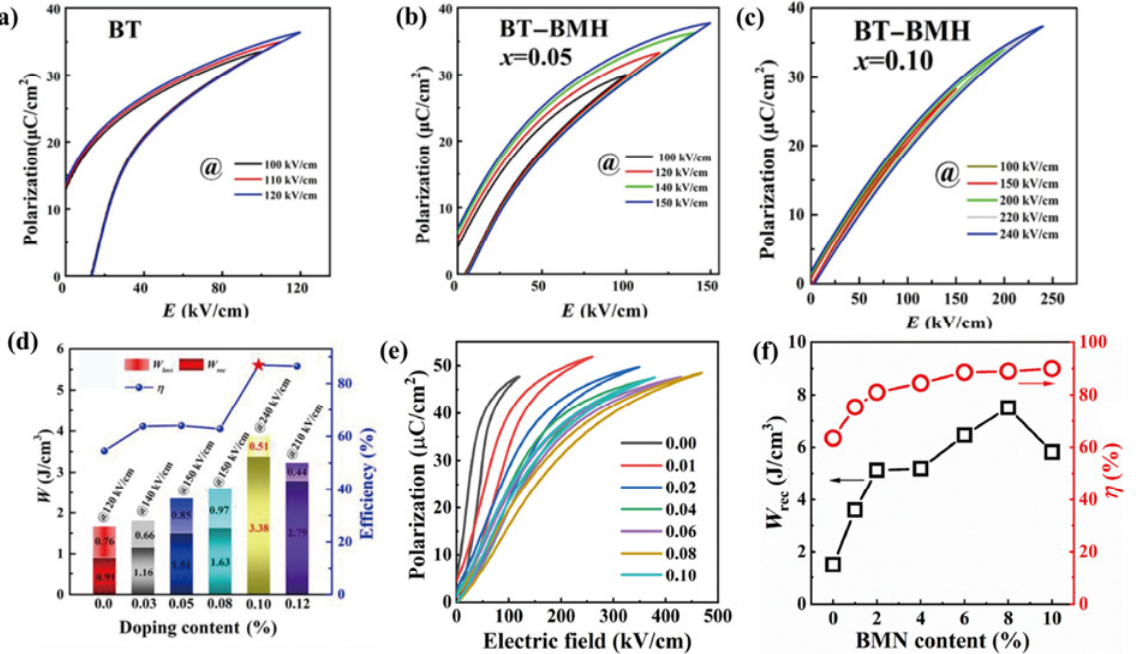
Fig. 12 (a–c) P – E loops and (d) energy storage performance of BT–BMH ceramics. (e) P – E loops and (f) energy storage performance of BNT–SBT–BMN ceramics. Reproduced with permission from Ref. [84] for (a–d), © Elsevier B.V. 2021; Ref. [47] for (e, f), © Elsevier B.V. 2021. Table 2 Energy storage performance of ceramics containing Bi(Me'Me'')O 3 Composition P max ( μ C/cm 2